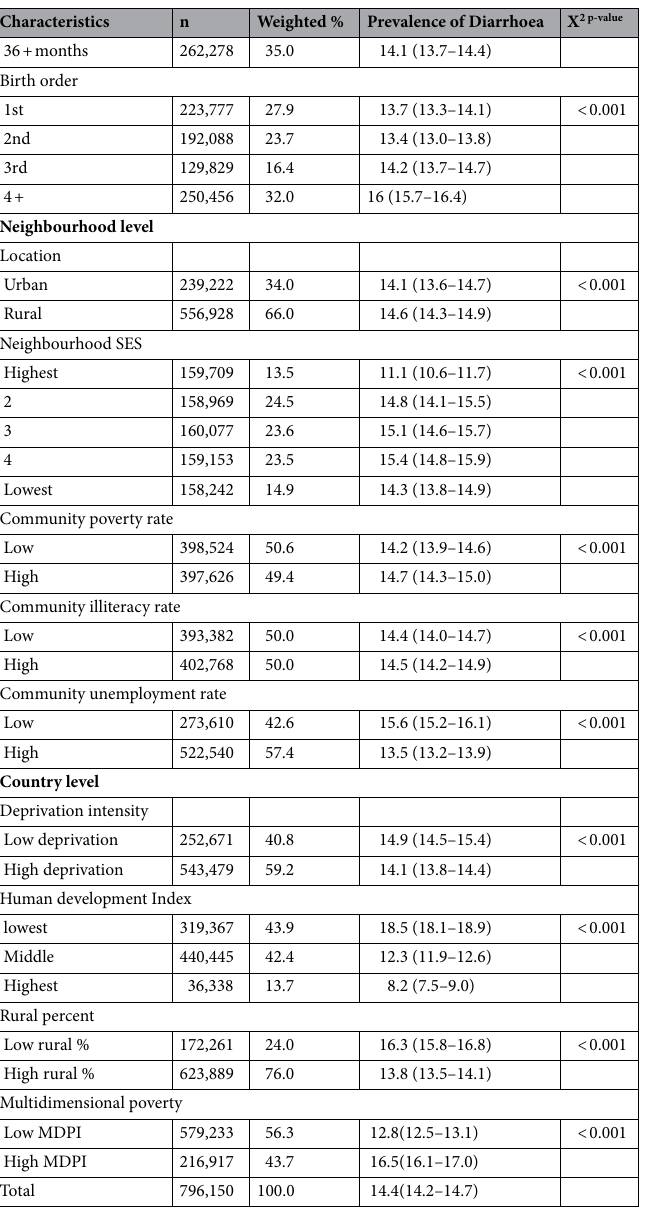
Table 2. Description of background characteristics and diarrhoea prevalence among under-five children in LMIC, DHS